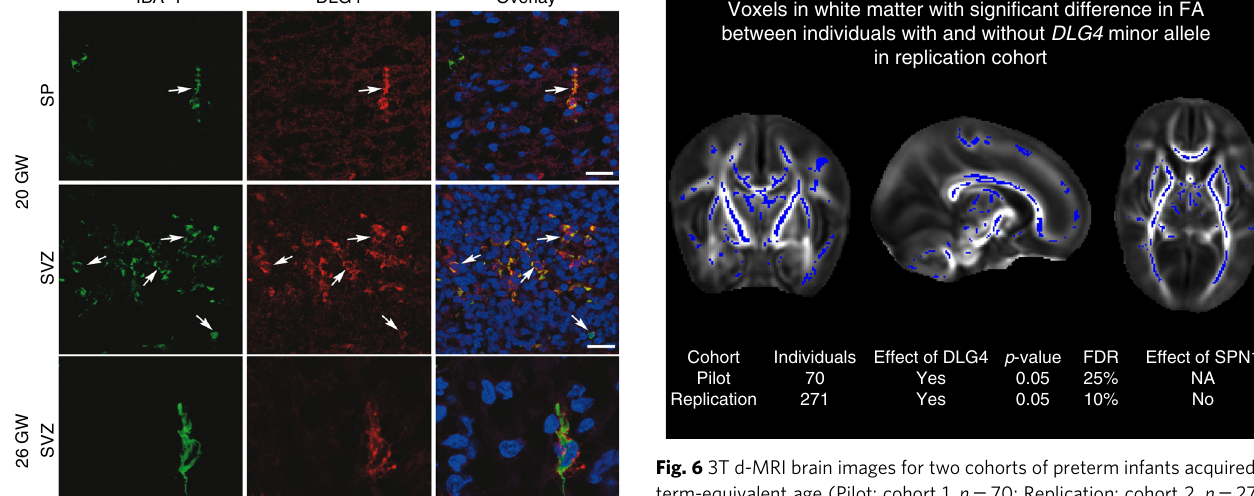
(TBSS) (Supplementary Methods). DNA extracted from saliva was genotyped on the Illumina HumanOmniExpress-12 array.